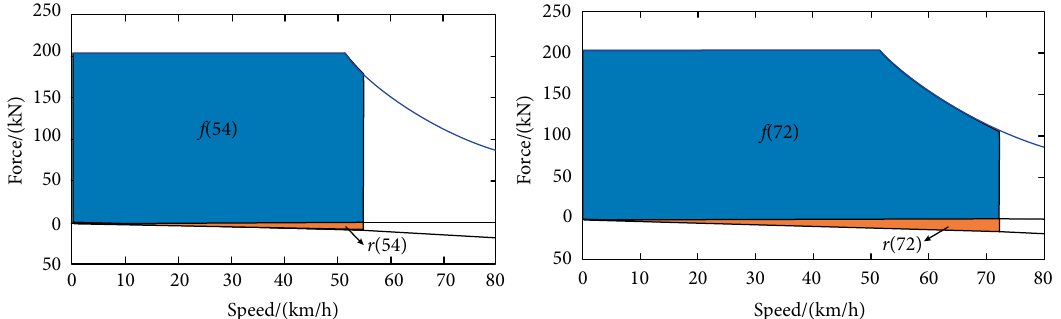
Figure 3: Integral diagram of traction force (blue line) and basic resistance (black line).